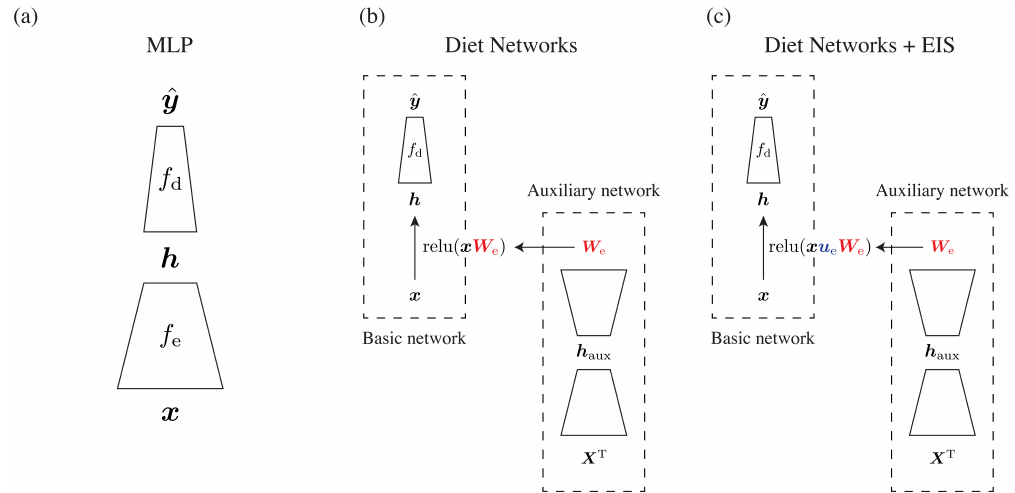
Figure 1. Overview of network architectures investigated in the present study. ( a ) Multilayer perceptron (MLP) consists of three-layered fully-connected networks; its overall architecture is the same as that of the basic network of Diet Networks. ( b ) The original Diet Networks concept approximates two fat layers, W e and W r (only W e is shown here), by the auxiliary networks taking the transposed data matrix as their input. ( c ) Our modification to Diet Networks. Applying element-wise input scaling (EIS) provides a learnable vector u e to the input, which is directly optimized through backpropagation of gradients from the output ˆ y to the input x . On the other hand, W e is estimated by the auxiliary network. Two auxiliary networks are introduced to alleviate parameter explosions in the basic